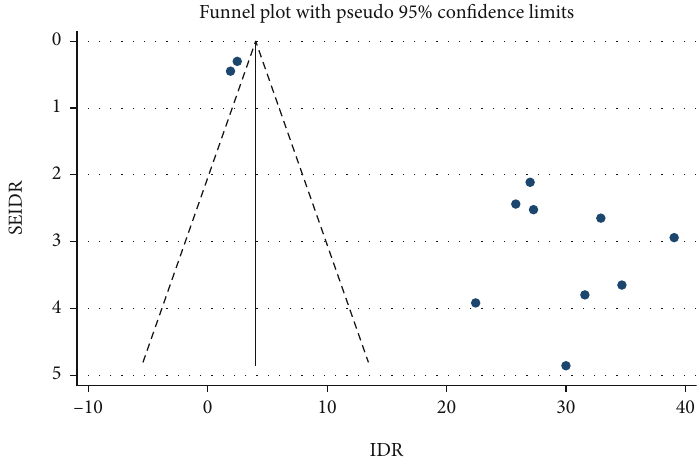
Figure 5: Funnel plot showing publication bias among studies used to compute the IDR of NM among neonates treated in the NICUs of